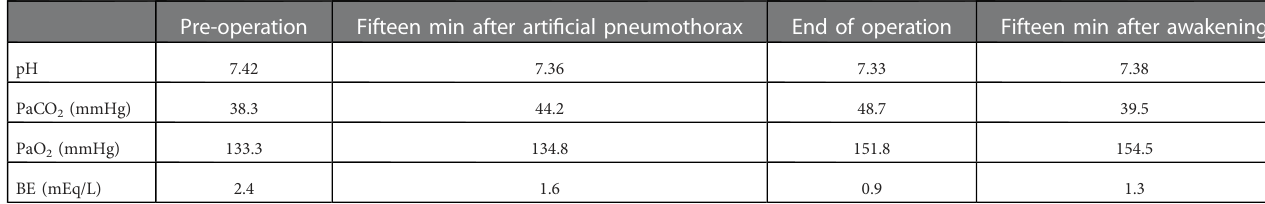
TABLE 1 Perioperative arterial blood gas analysis